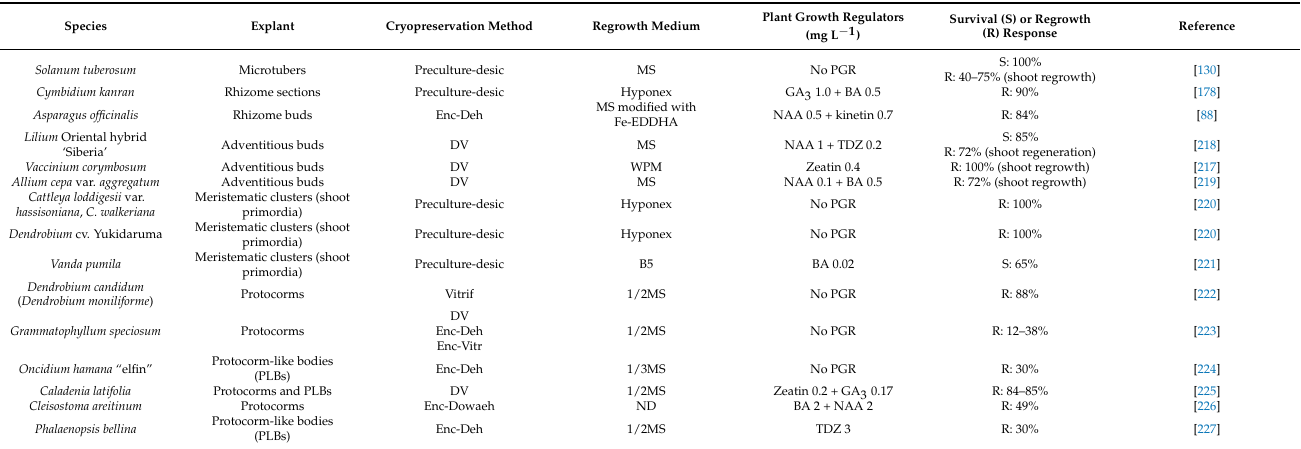
Table 6. Examples of plant growth regulators used at the recovery step during cryopreservation of tubers, rhizomes, adventitious buds, protocorms, and protocorm-like